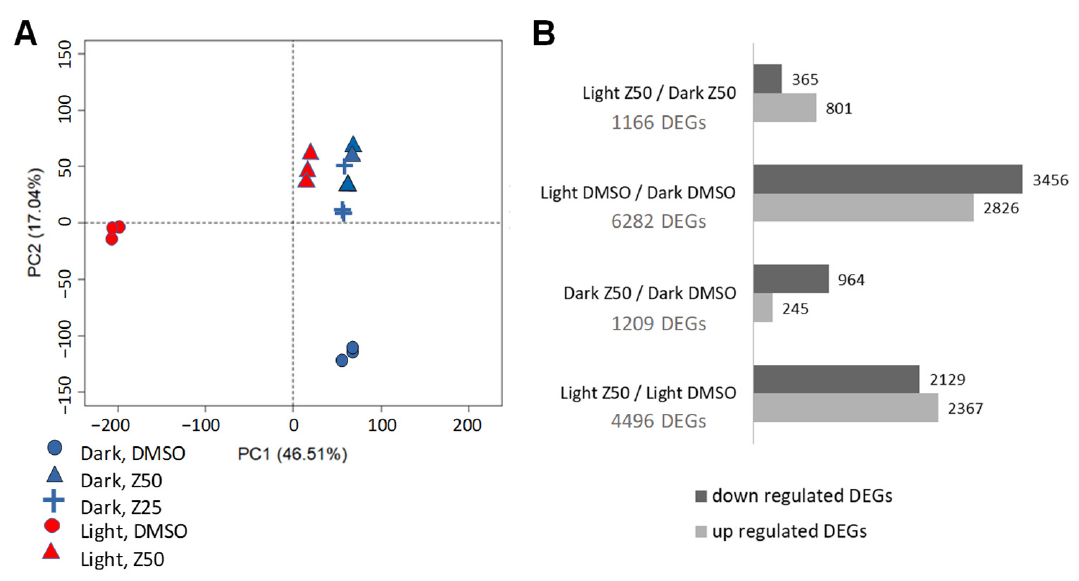
Figure 5. Transcriptome response to zebularine treatment in the light and in the dark. ( A ) Principal component analysis illustrating the relationships of the RNA-seq libraries generated from five different cell suspensions: light grown cells treated with DMSO or zebularine 50 μ M and dark grown cells treated with DMSO or zebularine 25 or 50 μ M. ( B ) Number of differentially expressed genes (DEGs) obtained by DESeq2 analysis for each cell growth condition except dark, Z25.